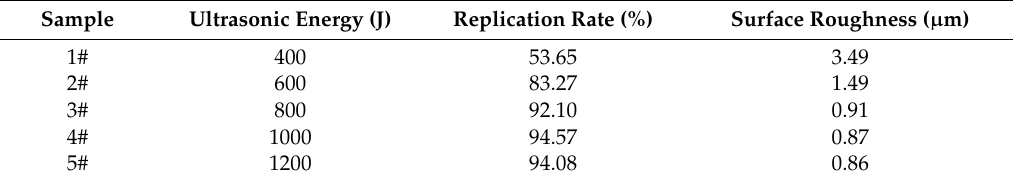
Table 3. Replication rate and surface roughness of micro-structured part fabricated under different welding pressures.